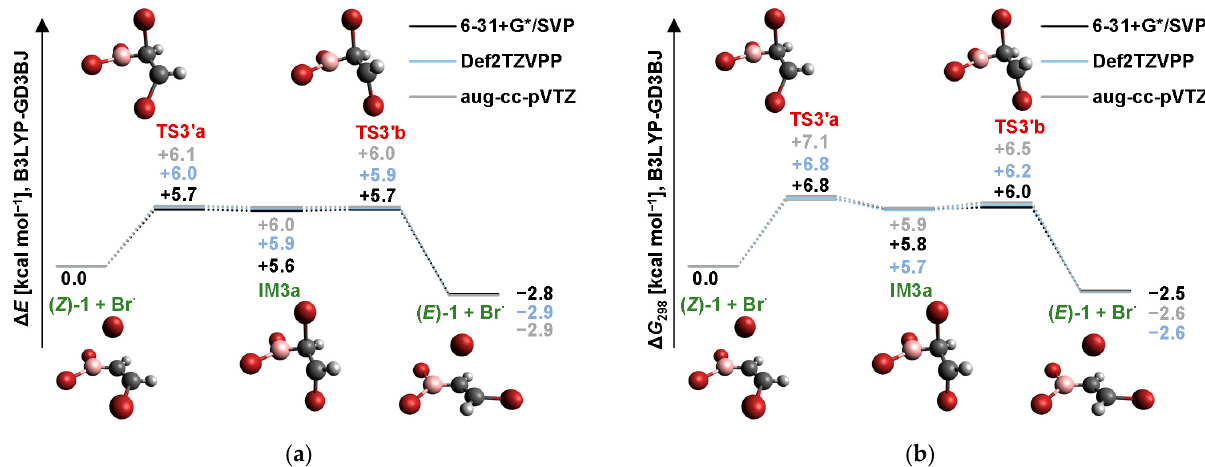
Figure 11. B3LYP electronic energy (a) and Gibbs free energy (b) profiles for bromine radical addition to the “boron end” of ( Z )-1 followed by anticlockwise rotation around the C–C bond. ZPE corrections, thermal corrections to enthalpy, and entropy contributions to Gibbs free energy were in all cases determined using same basis set as for the electronic energy contribution. For a key to atom color scheme, cf. caption of Figure 1.